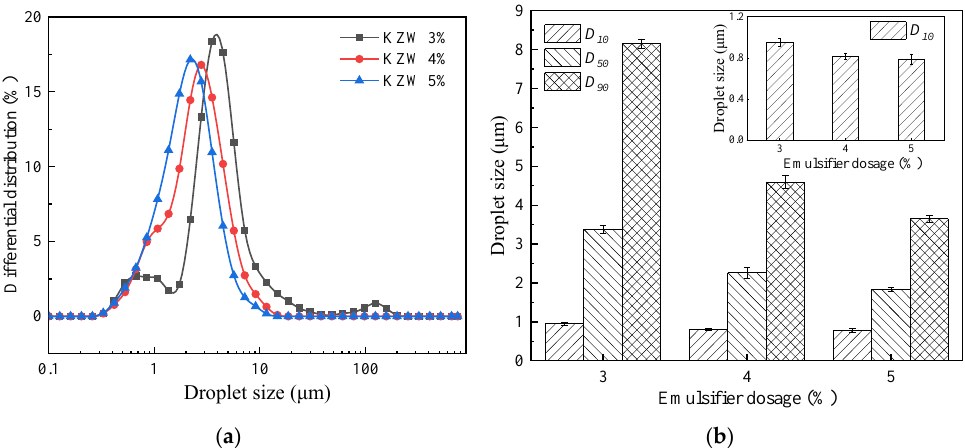
Figure 2. Droplet size distribution of asphalt emulsion with different emulsifier dosages. ( a ) Droplet size distribution; ( b ) Representative droplet sizes.